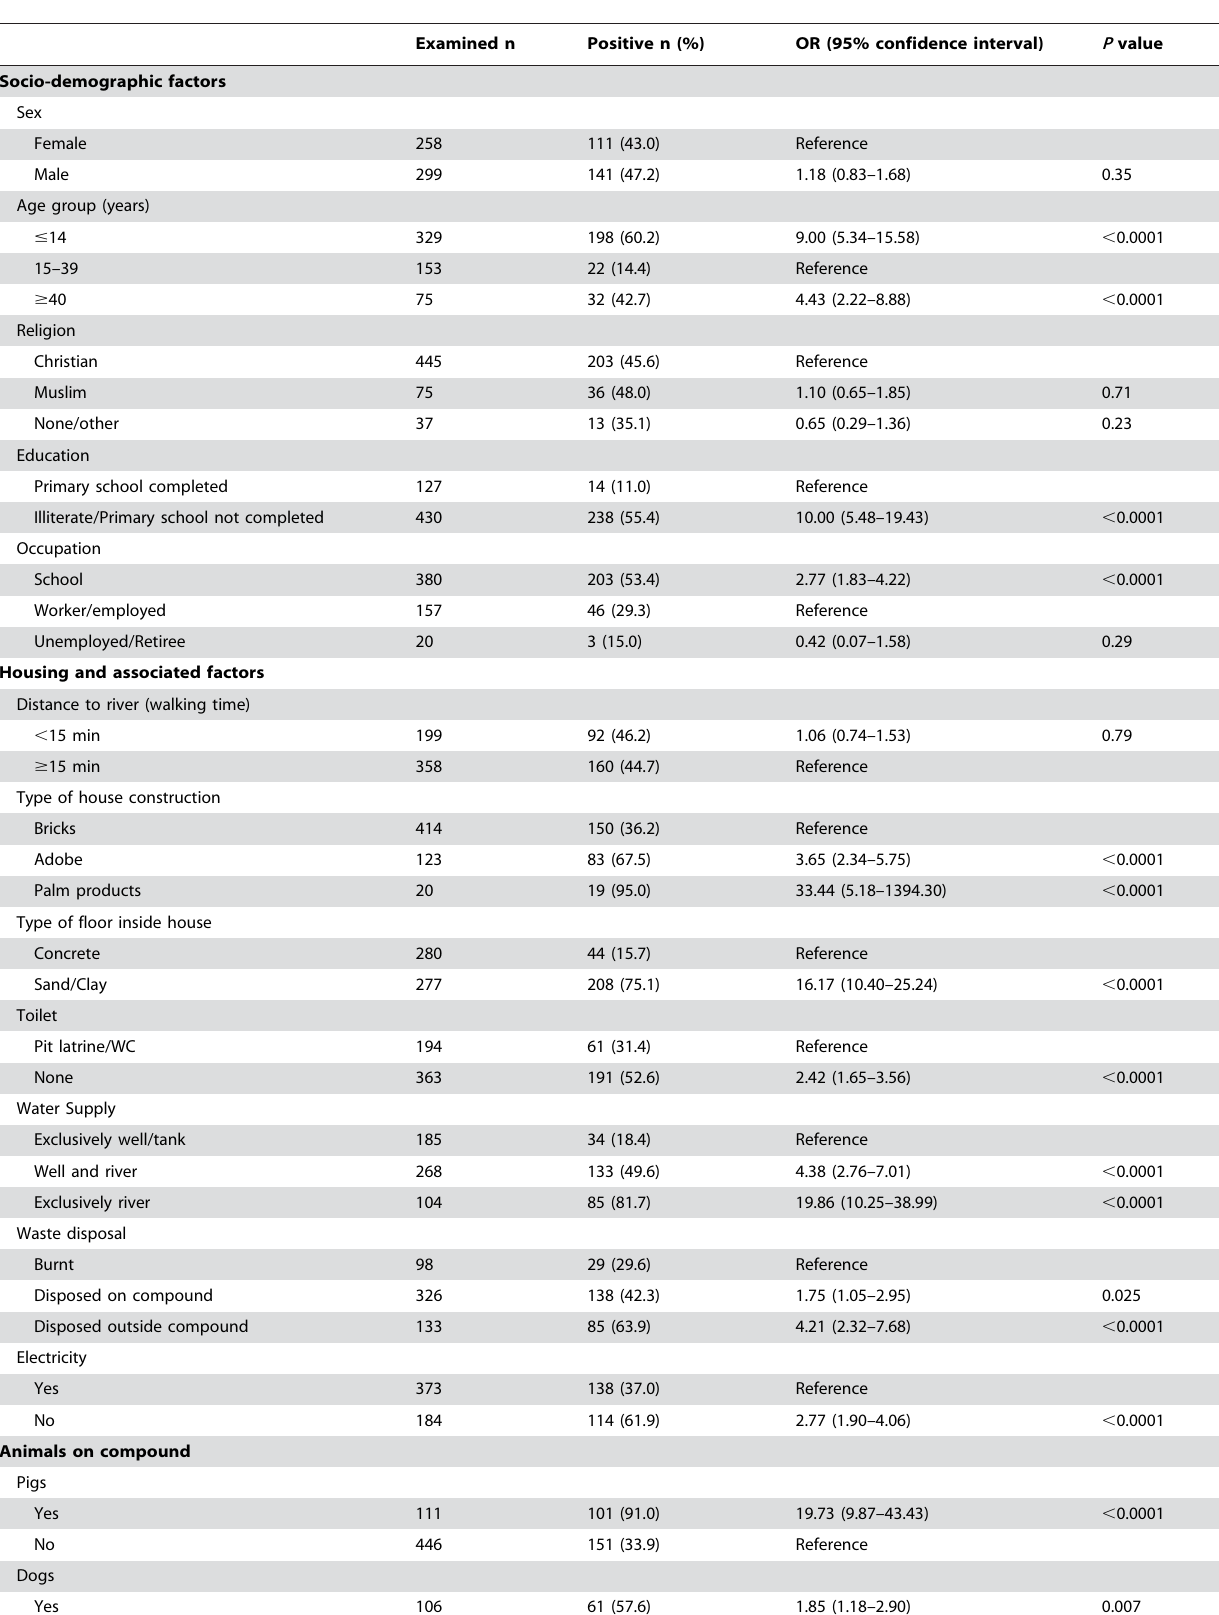
Table 1. Bivariate analysis of factors associated with tungiasis infestation.